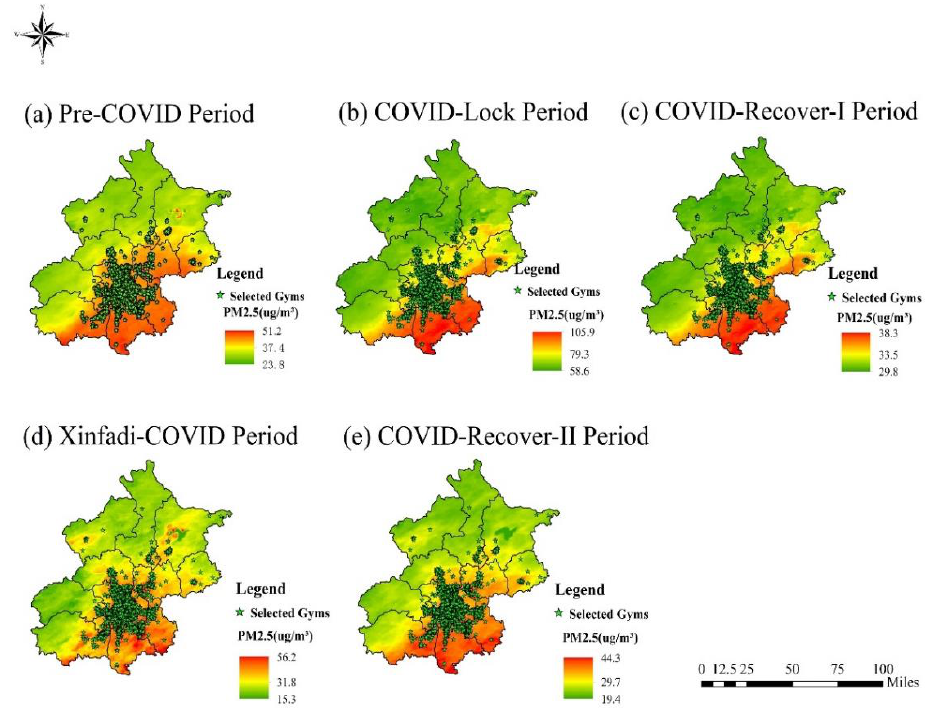
Figure 4. Spatial distribution of simulation results of PM2.5 concentrations in Beijing in P1 – P5.